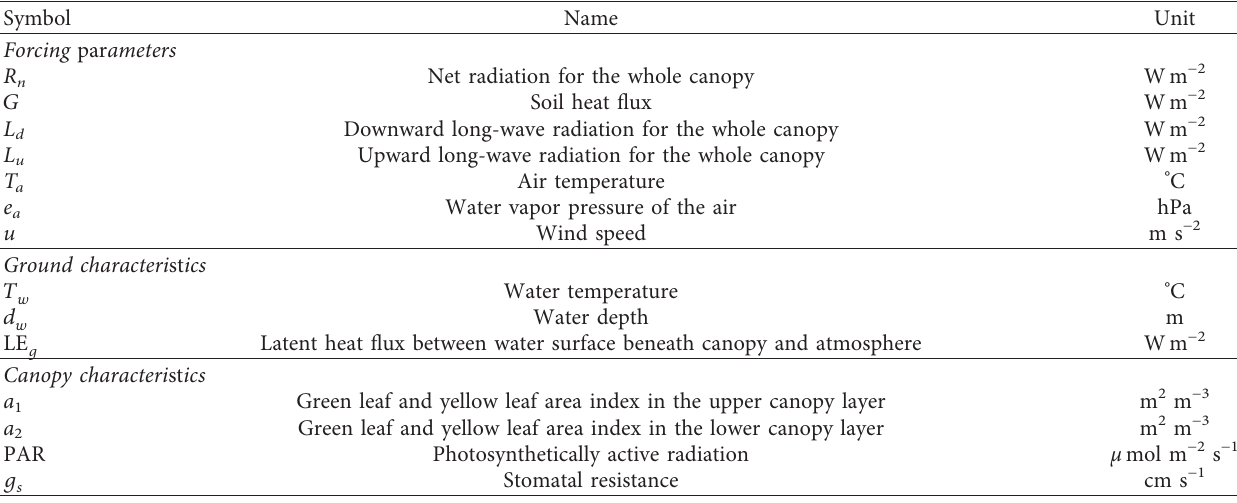
Table 1: Input parameters required for the calculation in the three-layer